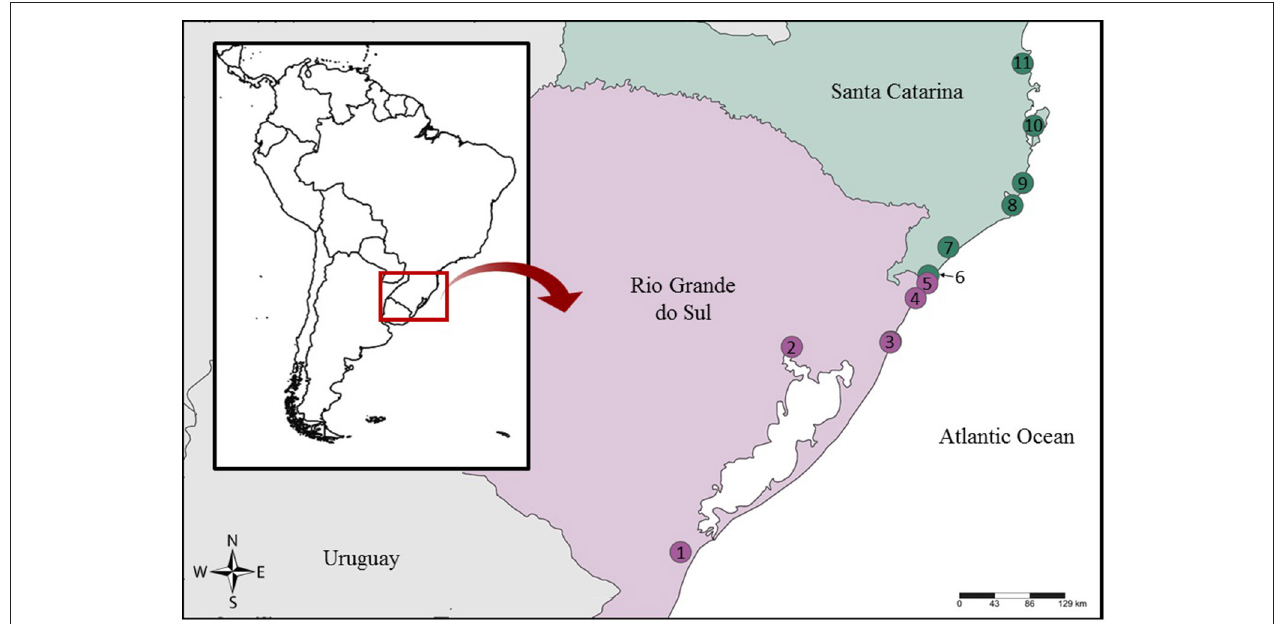
FIGURE 1 | Sampling locations in Southern Brazil. 1, Rio Grande; 2, Porto Alegre; 3, Tramandaí + Imbé; 4, Arroio do Sal; 5, Torres; 6, Passo de Torres; 7, Araranguá; 8, Laguna; 9, Imbituba; 10, Florianópolis; 11, Itajaí.